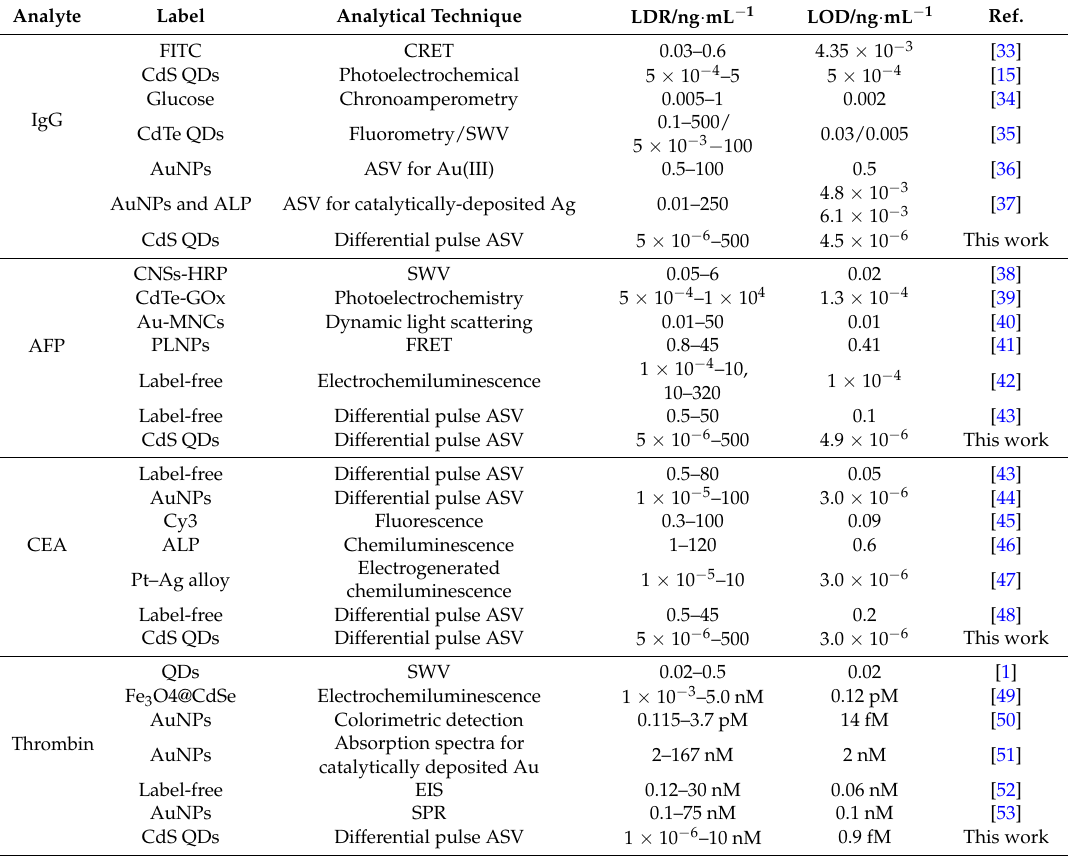
Table 1. Comparison of some sandwich-type bioelectrodes for bioassay